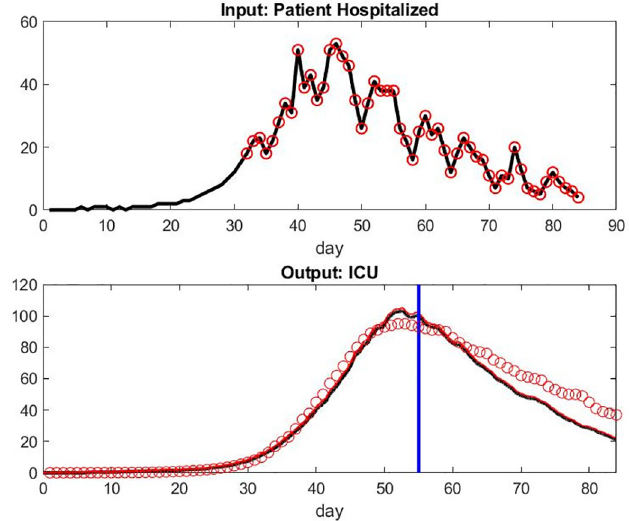
Fig 14. Top: Input of Patient Hospital Admission in France with 4 more weeks of data to validate our parameters. Bottom: Model of Patient Under Mechanical Ventilation in ICU Versus Data Set and predicted number of patient under mechanical ventilation in ICU on the right of the vertical blue line.